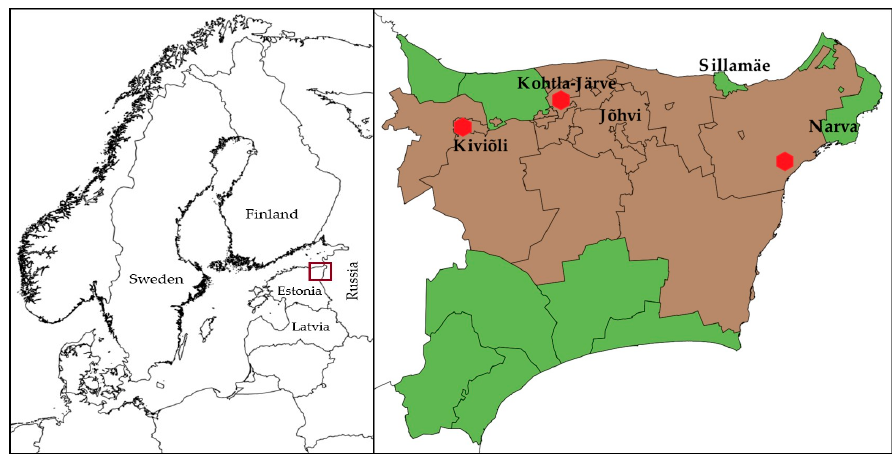
Figure 1. Map of Northern Europe showing the location of Estonia (left). Map of Ida-Viru County, Estonia, showing different municipalities (right). Municipalities under observation: oil-shale production and mining areas — brown, non-oil shale areas — green. The locations of shale oil extraction facilities are shown as red dots. The maps were made with QGIS 2.18 software. The administrative boundaries were provided by EuroGeographics and Estonian Land Board [56, 57].